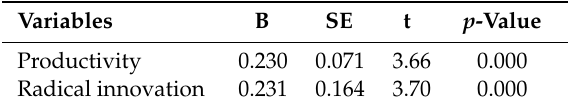
Table 3. Regression